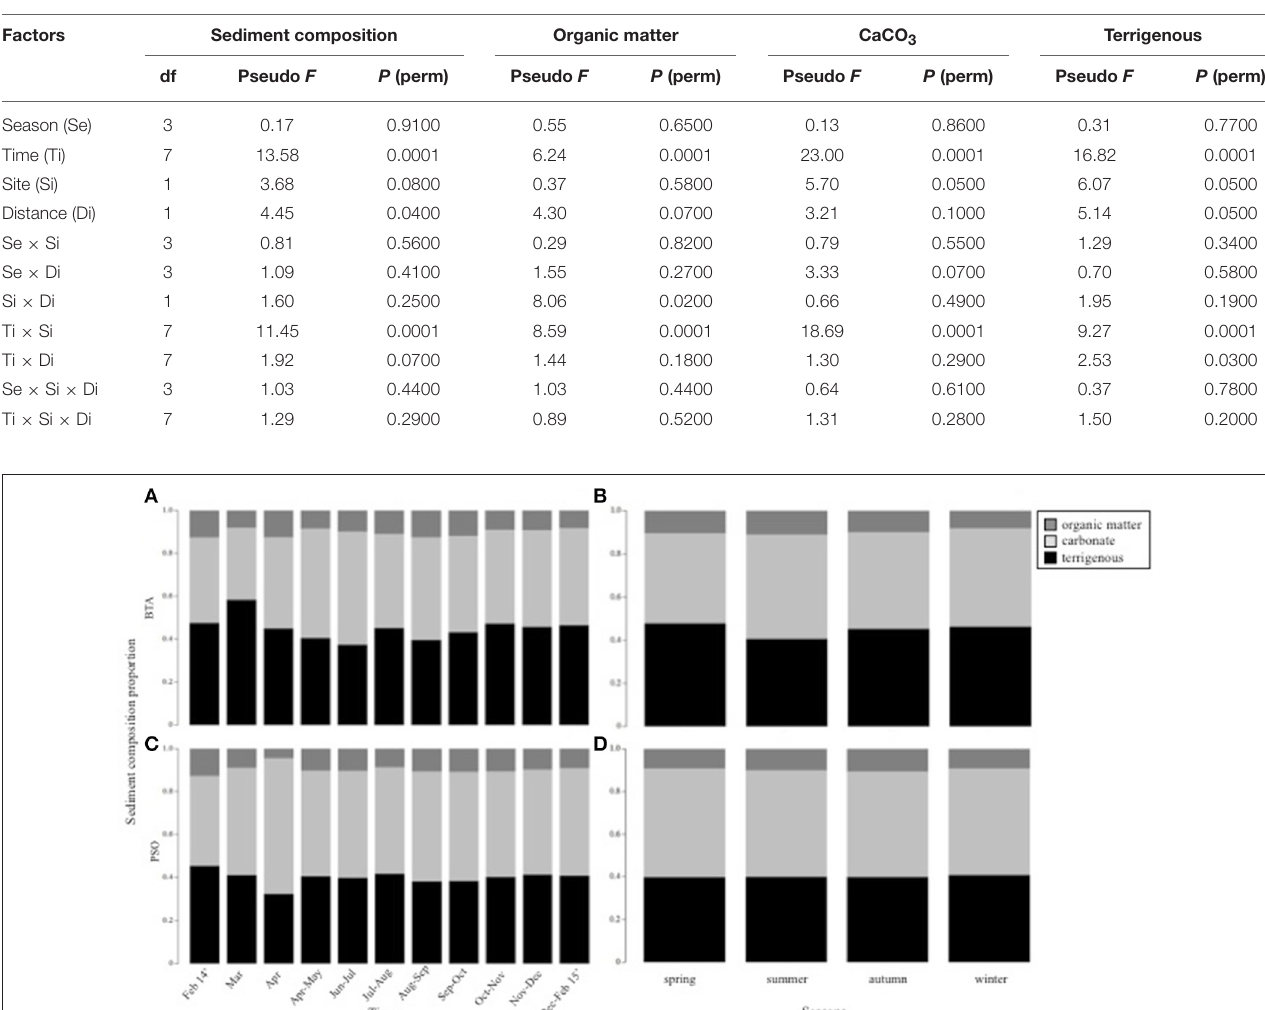
TABLE 3 | Permutational analysis of ANOVA (PERMANOVA) for sediment composition, organic matter, CaCO 3 , and terrigenous content of sediments. Factors